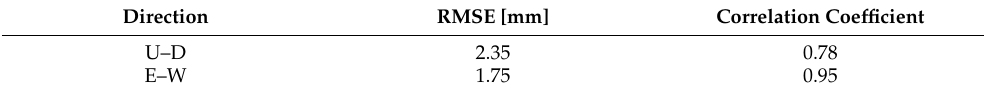
Table 7. RMS error and correlation coefficient for each calculated direction.